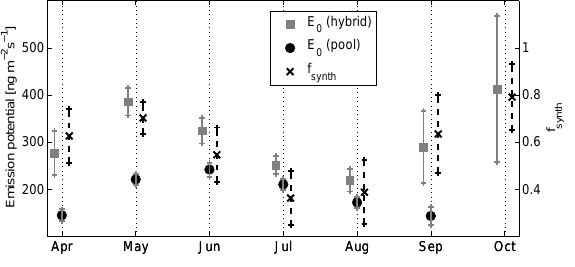
Figure 5. Monoterpene emission potentials of both hybrid algo- rithm and pool algorithm, and f synth for each month (years 2010– 2013). Plus signs show 95% confidence intervals (Table 4). Figure 6. Diurnal cycles (hourly medians) of monoterpene fluxes from March until November (years 2010–2013). The measurements were performed at 0200, 0500, 0800, 1100, 1400, 1700, 2000, and 2300 UTC+2, and the dashed lines represent the noon